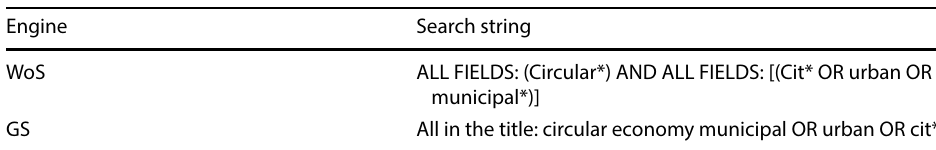
Table 2 Search string and databases for our evidence map